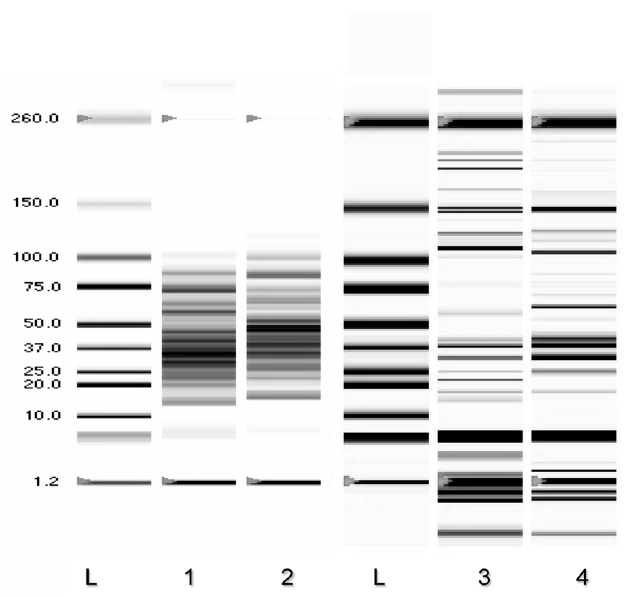
Figure 4. Capillary microelectrophoresis on specific microchip of crude homogenate (CHT) and extracellular protein phase (ET) of T. thermophilus grown in 0 and 100 ppm of Pb 2+ . L = Ladder standards; ( 1 ) CHT: crude homogenate of T. thermophilus ; ( 2 ) CHT + 100 ppm Pb 2+ : crude homogenate of T. thermophilus added at fermentation start time; ( 3 ) ET: extracellular phase of T. thermophilus ; ( 4 ) ET + 100 ppm Pb 2+ : extracellular phase of T. thermophilus added at the beginning of the incubation.